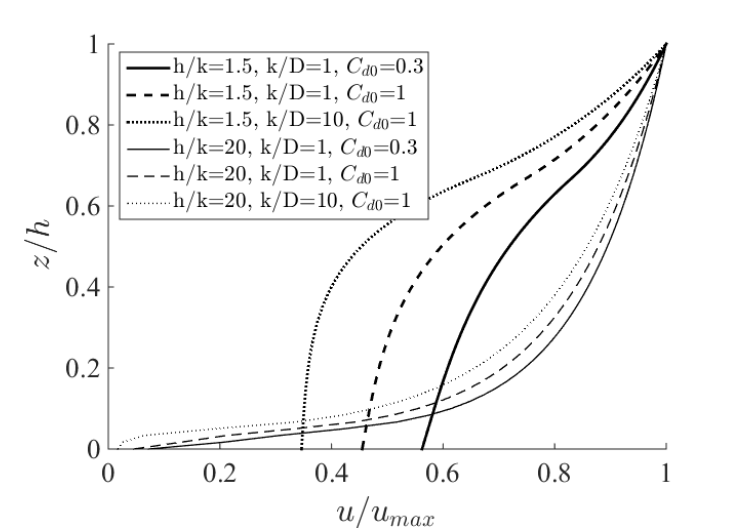
Figure 4. Velocity profiles from model as a function of hydraulic and geometrical parameters for weak and high confinement cases ( C =